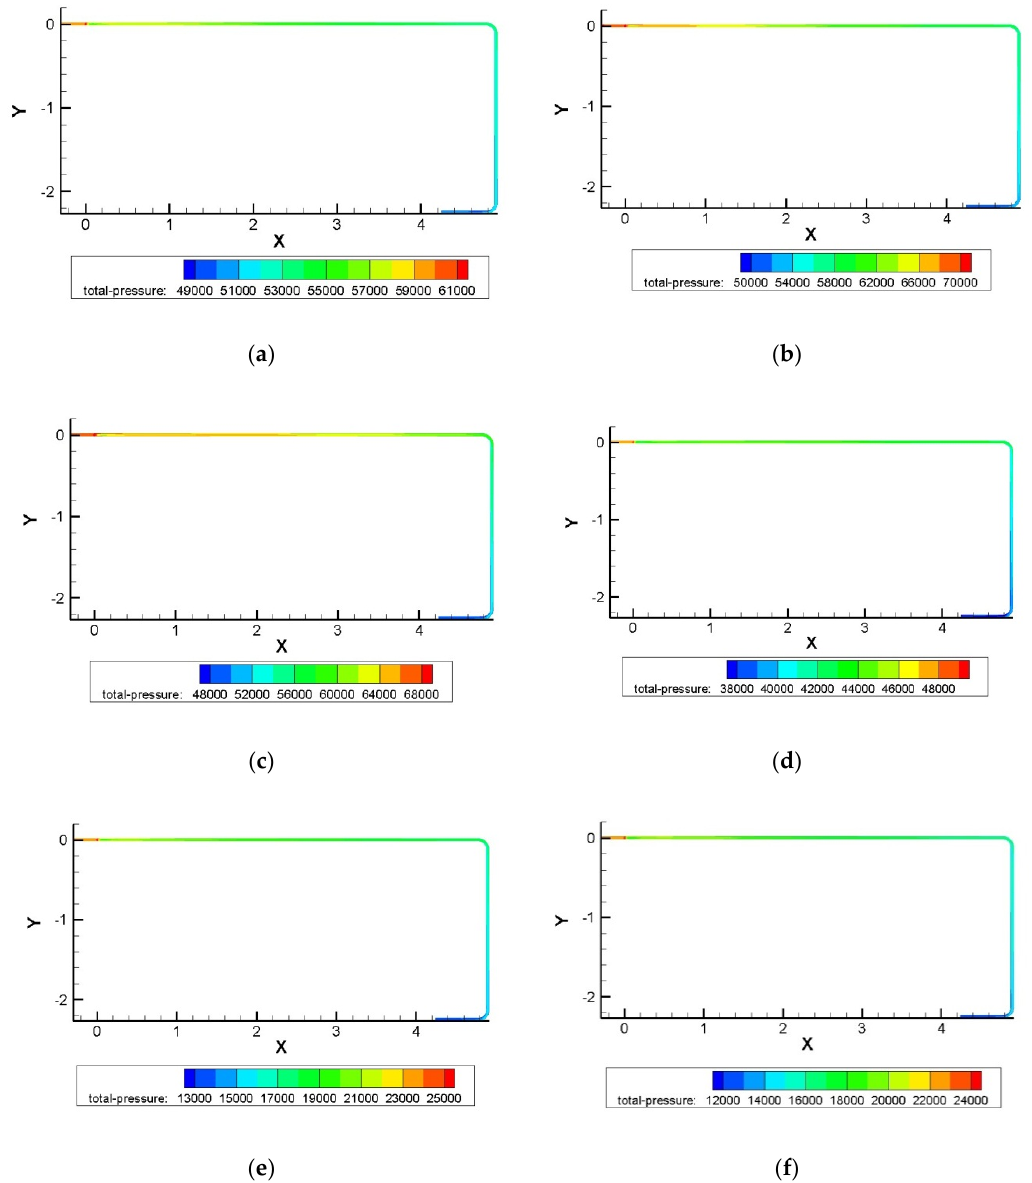
Figure 5. The pressure distribution of the horizontal axis intersecting surface within a period: ( a ) t = 0; ( b ) t = 2 s; ( c ) t = 4 s; ( d ) t = 6 s; ( e ) t = 8 s; ( f ) t = 10 s.